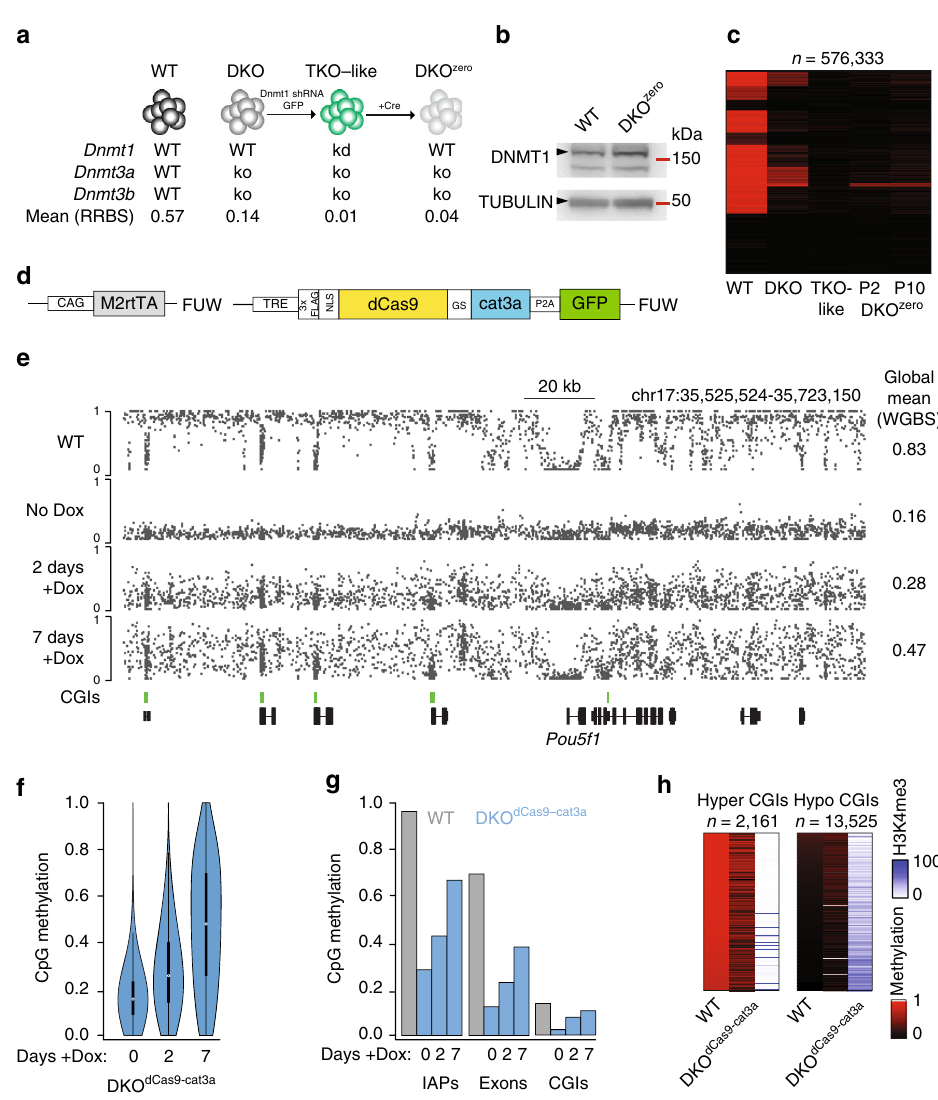
Fig. 1 Characterization of dCas9-cat3a activity in a methylation depleted cell line. a Overview of the multi-step generation of the Dnmt3 (de novo) free, maintenance competent, methylation depleted DKO zero ES cell line (see Methods section for details), WT = wild-type, kd = knock down, ko = knockout. Mean = mean methylation for matched CpGs measured by reduced representation bisul fi te sequencing (RRBS). b Western blot of DNMT1 (183 kDa) in WT and DKO zero cells. TUBULIN (50 kDa) serves as loading control. c Heatmap comparing global CpG methylation levels measured by RRBS in WT, DKO, TKO-like, early (P2) and late (P10) passage DKO zero cells. n shows the number of shared CpGs ( n = 576,333). d Simpli fi ed schematics showing the M2rtTA and dCas9-cat3a FUW-based lentiviral expression constructs. e Representative whole genome bisul fi te sequencing (WGBS) tracks displaying CpG methylation in WT as well as reset DKO dCas9-cat3a cells with 0, 2, or 7 days of Dox induction. Global mean CpG methylation levels are shown on the right. CpG islands (CGIs) are highlighted beneath in green. f Violin plots for matched CpGs in DKO dCas9-cat3a with 0, 2, and 7 days of Dox induction without the presence of an sgRNA. White dots indicate median values. g Mean CpG methylation across selected features in WT and DKO dCas9-cat3a cells with 0, 2, and 7 days of Dox induction. IAPs = intra-cisternal A-type particles (retrotransposons). h Heatmap for all hypermethylated CGIs (mean in WT > 0.8, left) and hypomethylated CGIs (mean in WT ≤ 0.2, right) in WT and DKO dCas9-cat3a cells induced for 7 days with Dox. H3K4me3 enrichment for each CGI in WT